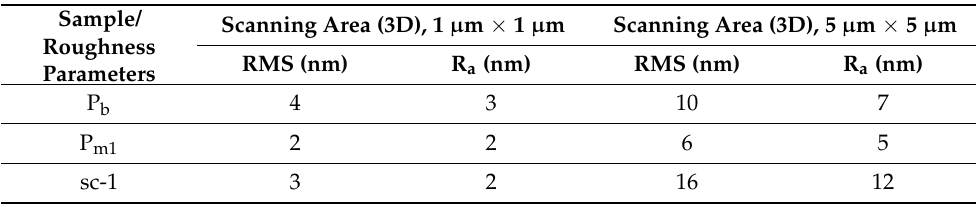
Table 7. The parameters, mean square roughness (RMS) and mean roughness (Ra) characterizing the roughness of the selected sc-1 compound